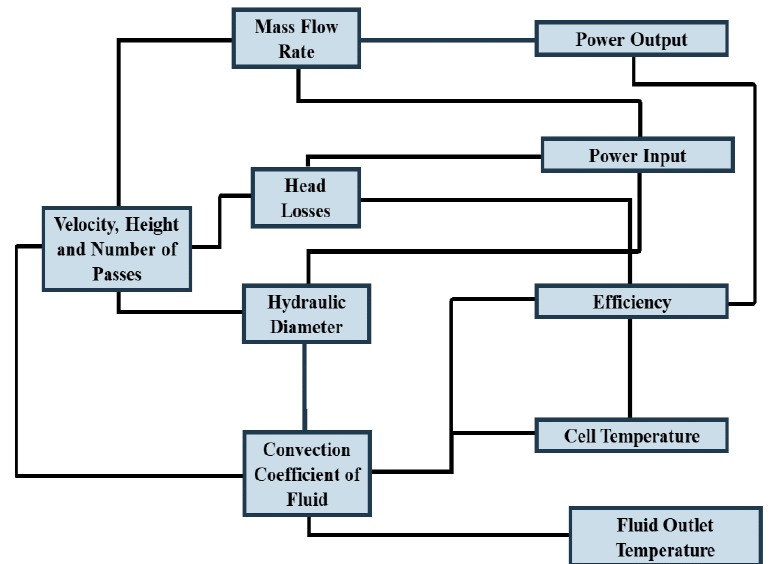
Figure 4. Schematic of multi-objective, multivariable genetic optimization algorithm.